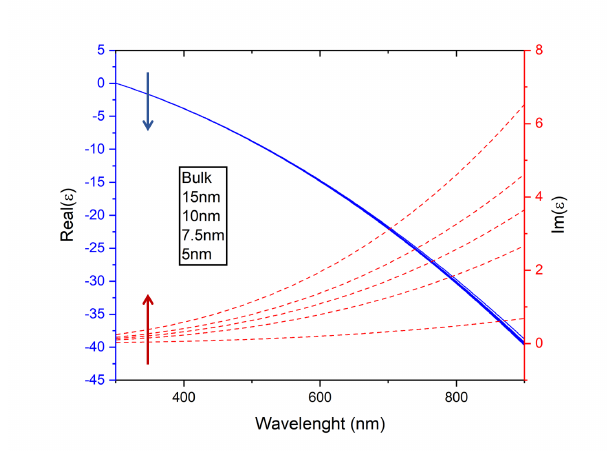
Figure 1: Drude’s model of the silver Permittivity as func- tion of the thickness, real part ( Real ( ε ) ) in blue and imagi- nary part( Im ( ε ) ) in red.